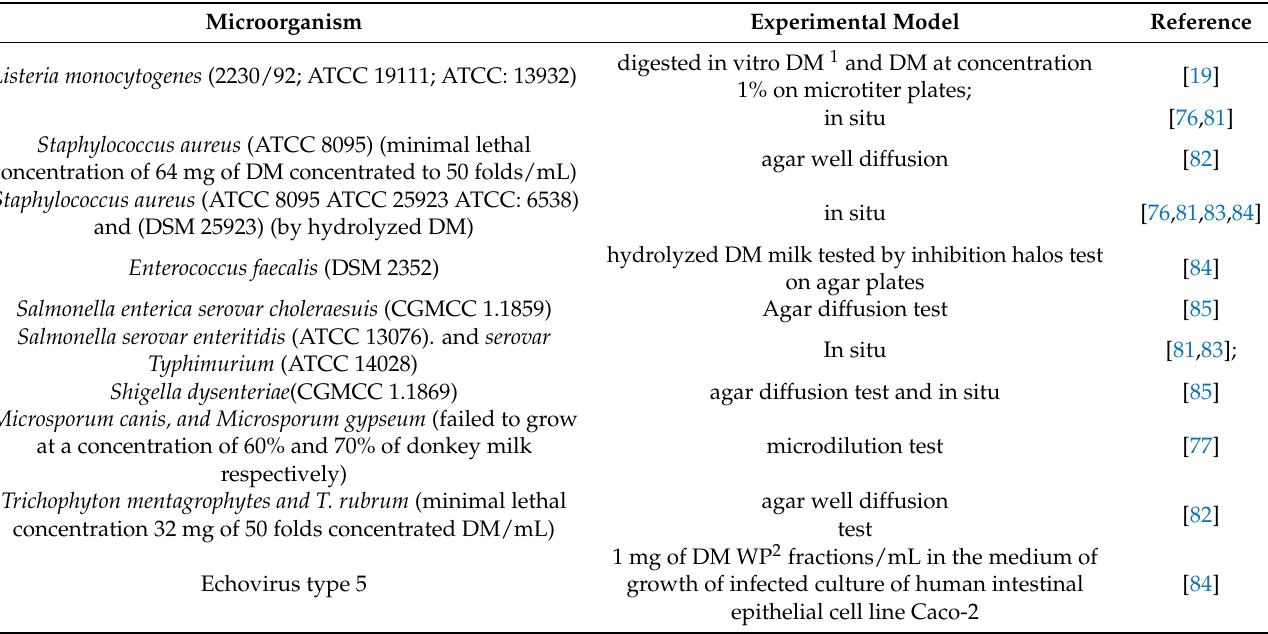
Table 5. Studies on effects against microorganisms of donkey